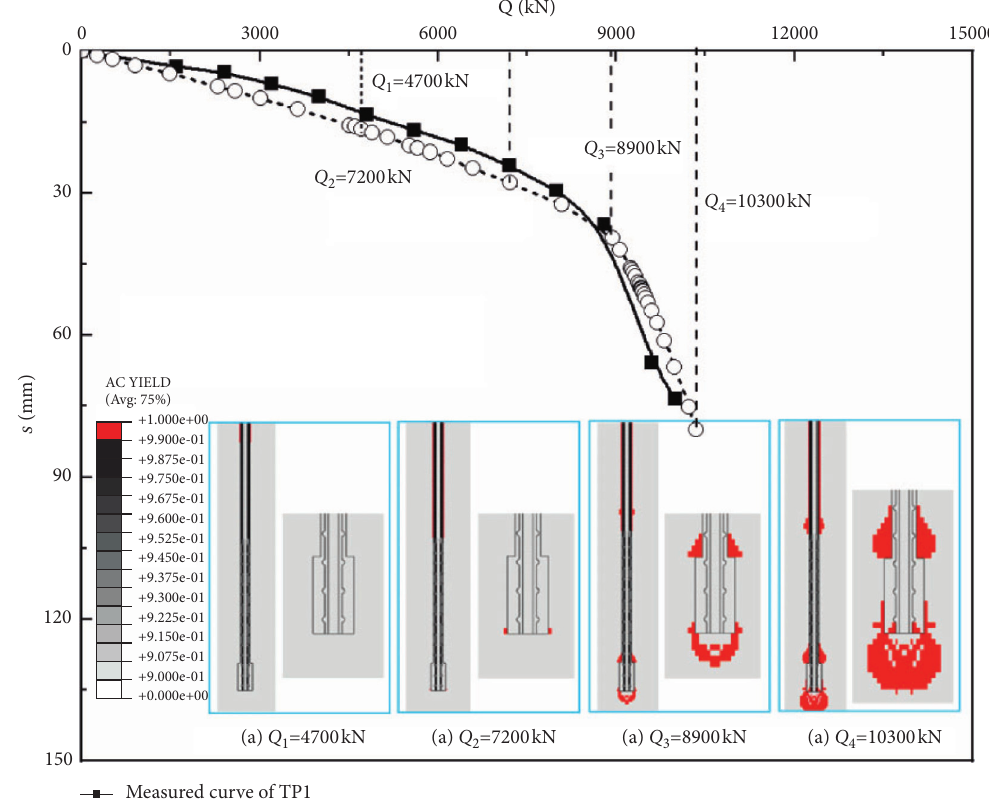
Figure 6: The development process of the yield zone around the pile and the enlarged